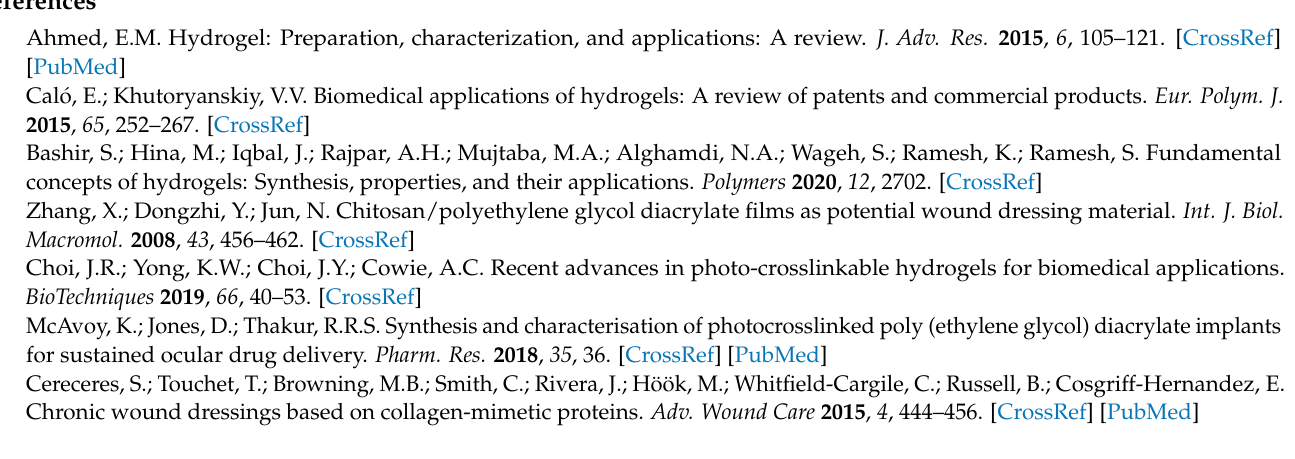
surfactant; Figure S2: Comparison between the average droplet size measured using the “Oval” tool in ImageJ ( D a ) and ImageJ’s Hough Circle Transform plugin ( D b ); Figure S3: Optical microscopy images of particles produced at different dispersed-to-continuous phase flow rate ratios; Figure S4: Images of PEGDA particles produced using different water contents in the dispersed phase and different UV exposure